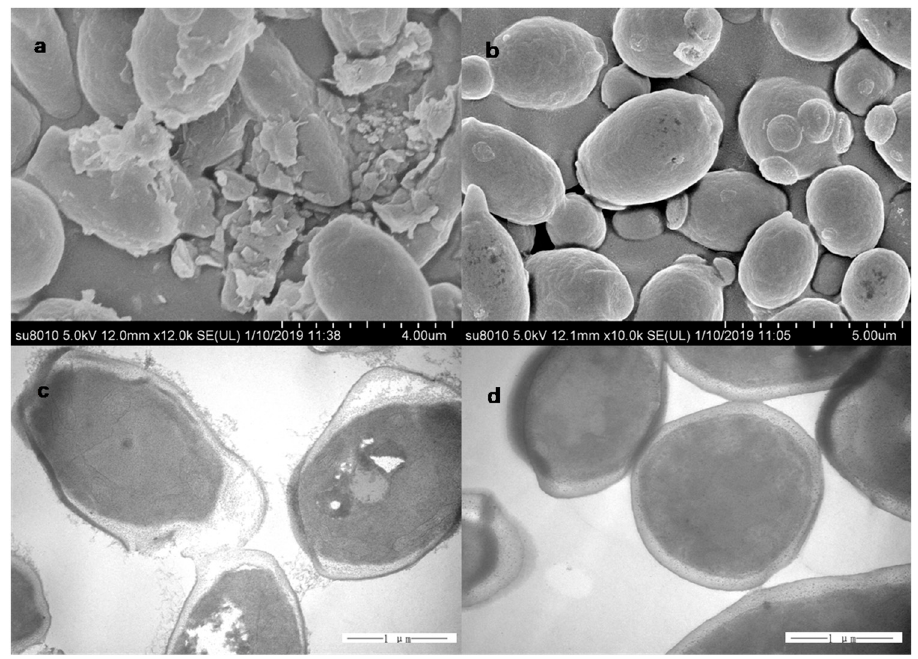
Figure 9. SEM and TEM micrographs of C. albicans cgmcc 2.2086 treated with potential peptide ( a and c ) or none ( b and d ).